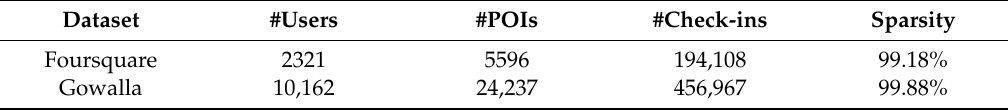
Table 2. Basic statistics of Foursquare and Gowalla